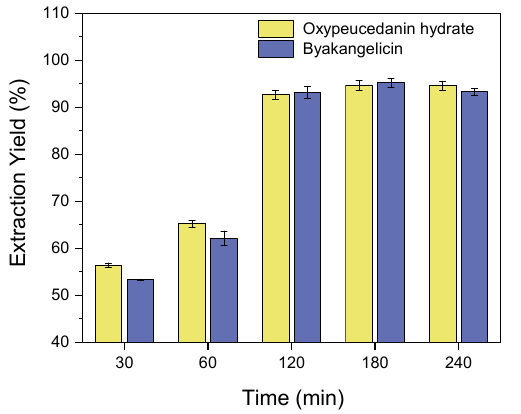
Figure 5. Effect of time on the extraction of oxypeucedanin hydrate and byakangelicin.